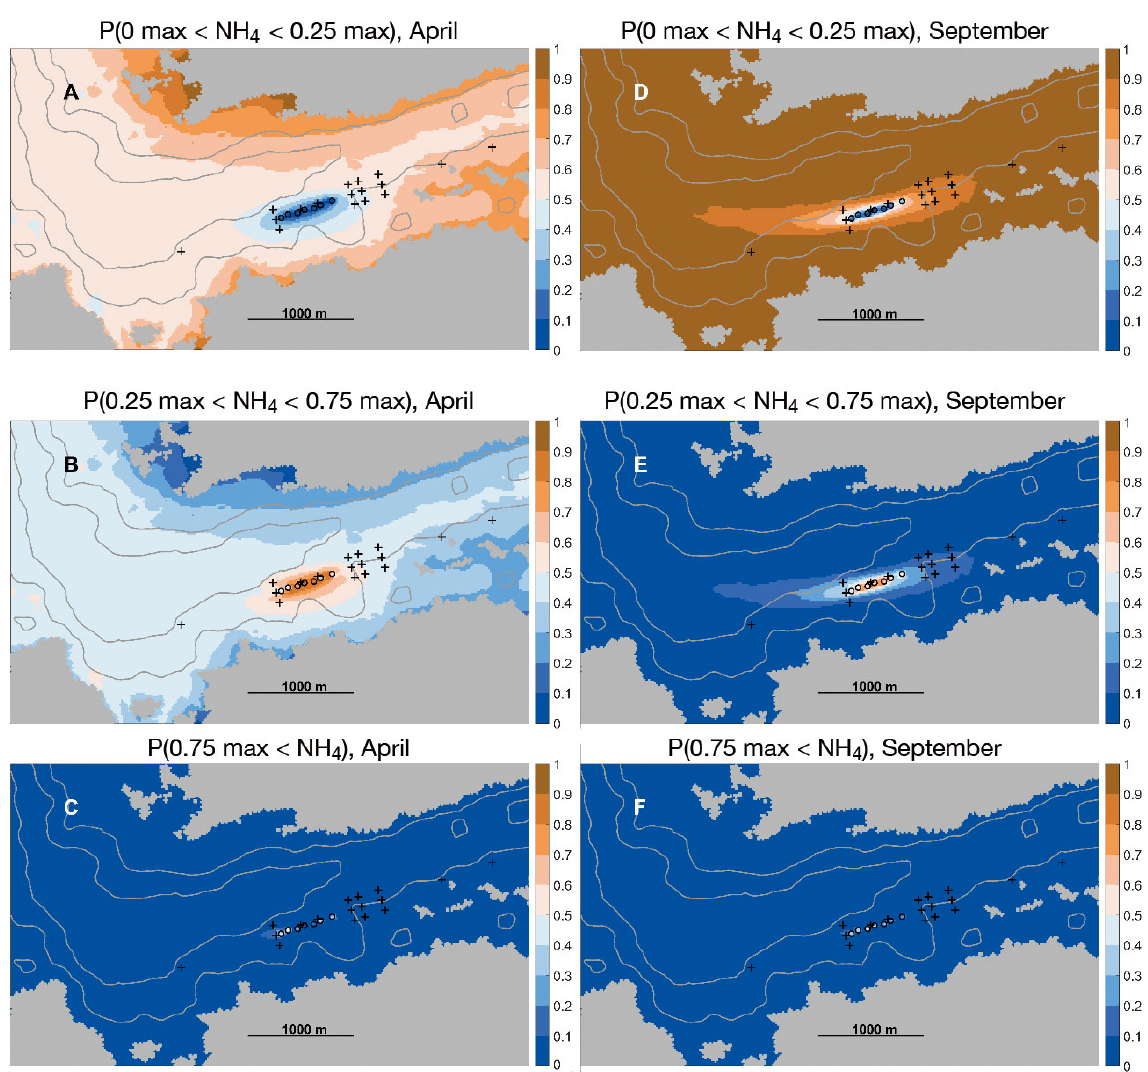
Fig. 7. Probability maps for simulated ammonium dilution in (A–C) April and (D–F) September. The colors represent the (tem- poral) probability of an ammonium concentration in a grid cell at (A,D) <25%, (B,E) between 25 and 75% or (C,F) >75% of the maximum concentration in the model domain for each (hourly) time sample